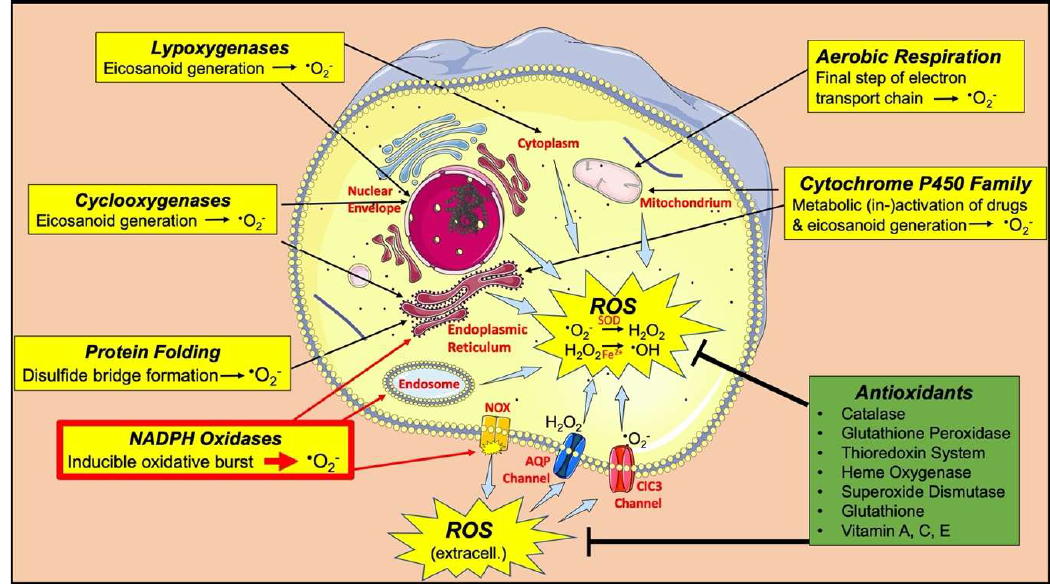
Figure 1. Major sources of reactive oxygen species (ROS) and antioxidant defense mechanisms. NADPH oxidases (NOX; highlighted in red) appear to be the most important source of ROS involved in processes related to the formation and resolution of venous thrombi.